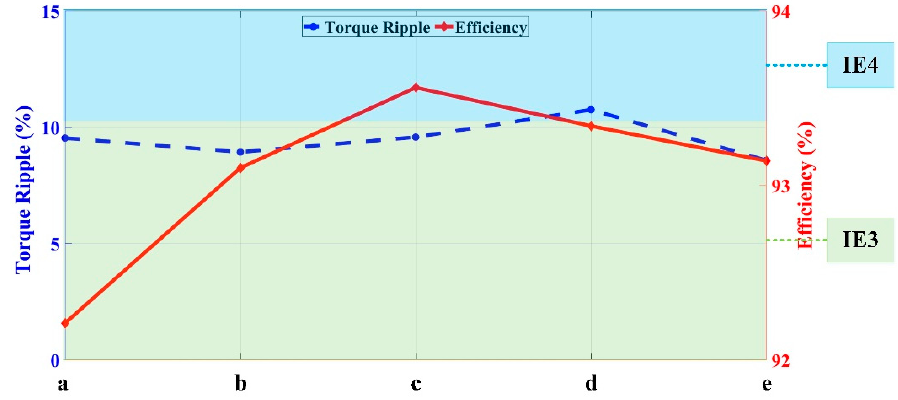
ffi ciency and torque results of SMC used Figure 13. Efficiency and torque results of SMC used AFIM. Figure 13. E